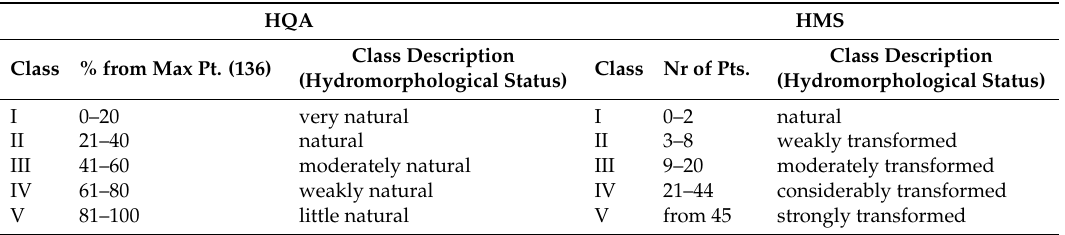
Table 1. Ranges of values of the Habitat Quality Assessment (HQA) and the Habitat Modification Score (HMS) for the classes of hydromorphological status [5]. HQA HMS Class Description Class % from Max Pt. (136) Class Nr of (Hydromorphological Status)